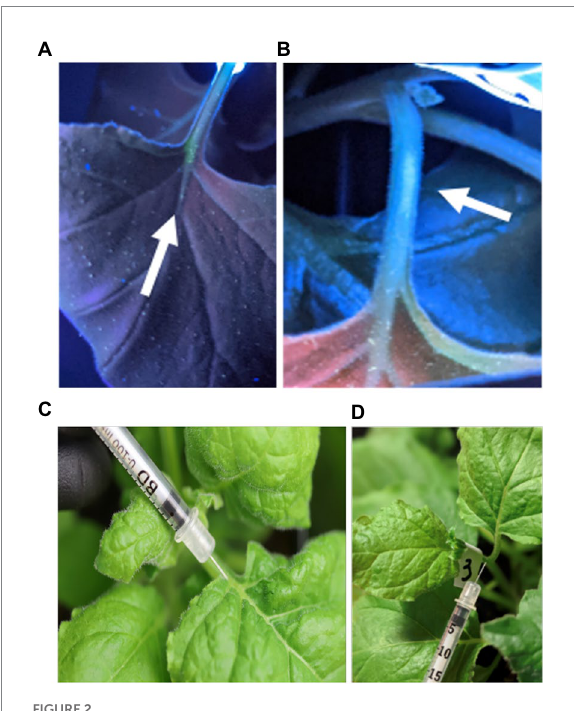
FIGURE 2 Photographic documentation of the injection of fluorophore Oregon Green 488TM into the petiole; plants were imaged under UV light (A,B) . Photograph of TMV injection into the petiole (C,D) .